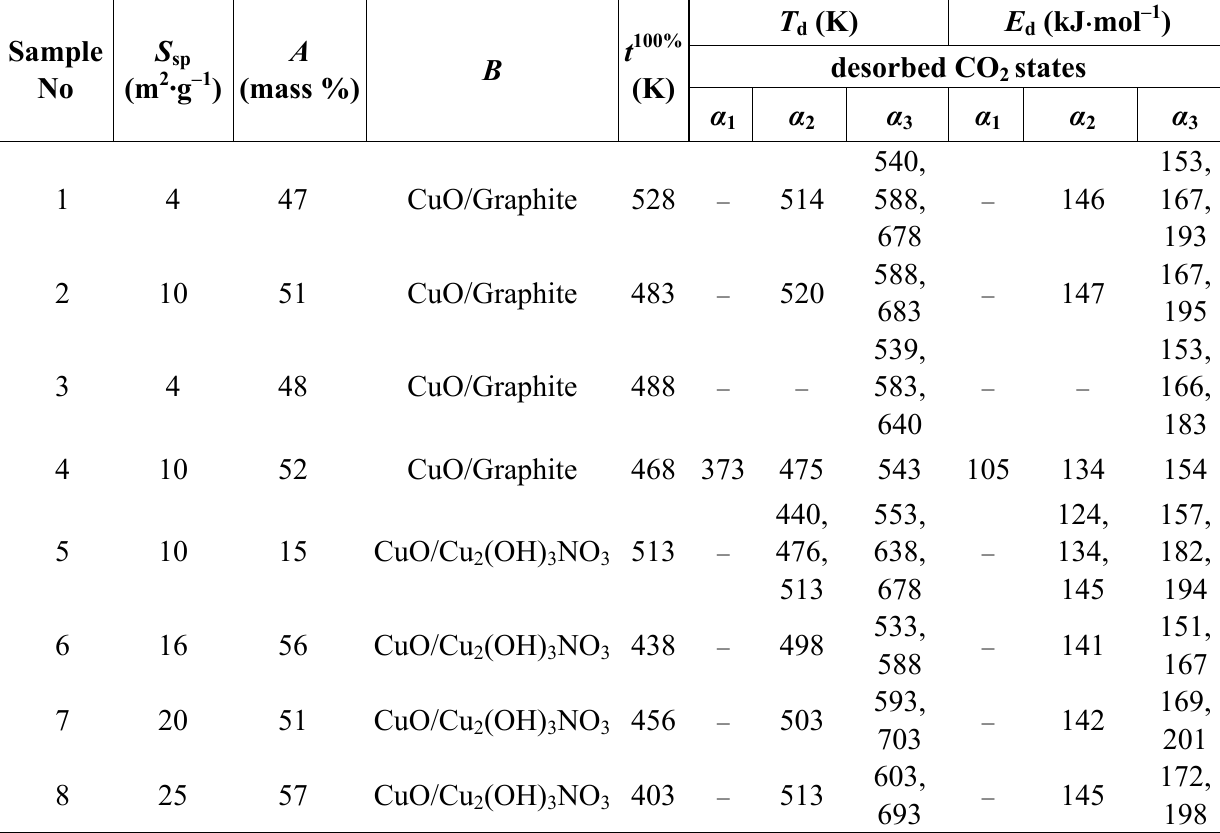
Table 1. Surface area ( S determined from PXRD data ( B ), the temperature at 100% conversion of CO to CO ( t 100% ), the peak temperature ( T TPD MS